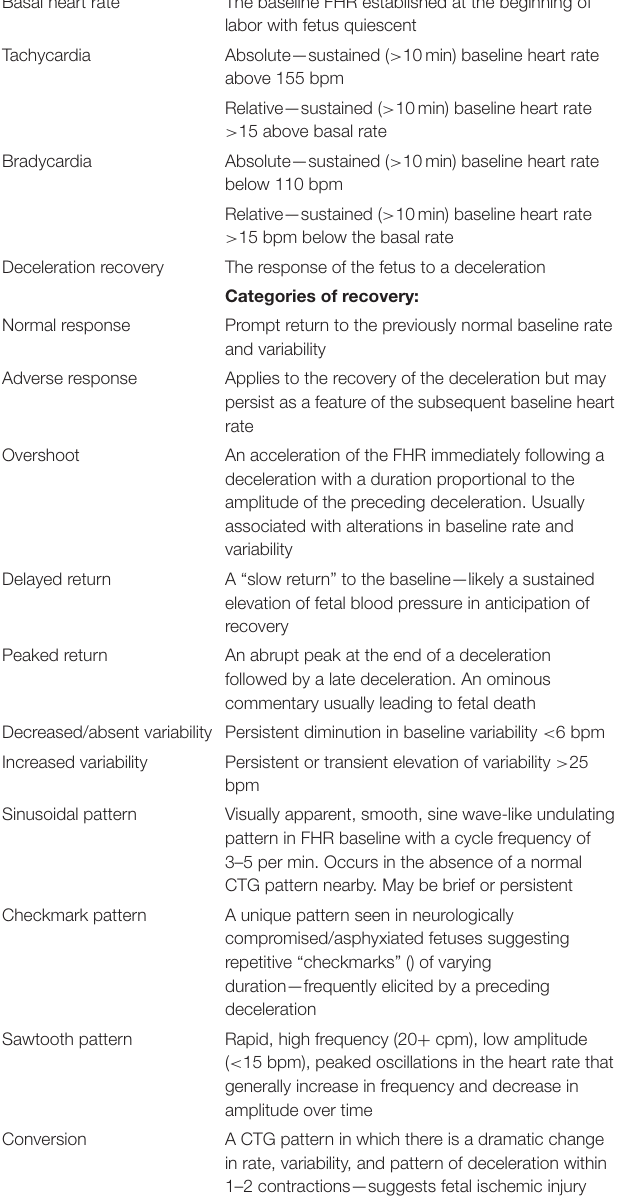
TABLE 1 | Definitions of EFM patterns. Basal heart rate The baseline FHR established at the beginning of labor with fetus quiescent Tachycardia